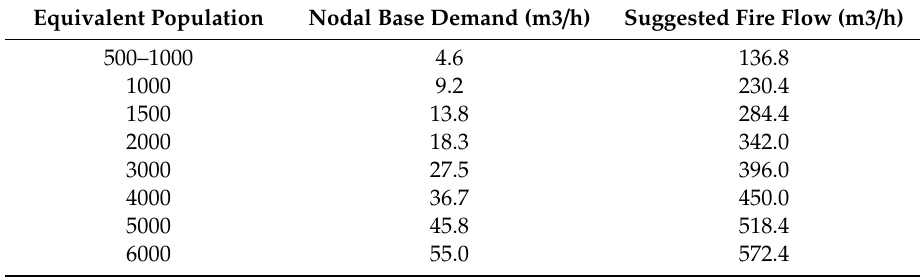
Table 2. Estimation of fire flow requirements (OMOECC [37]).